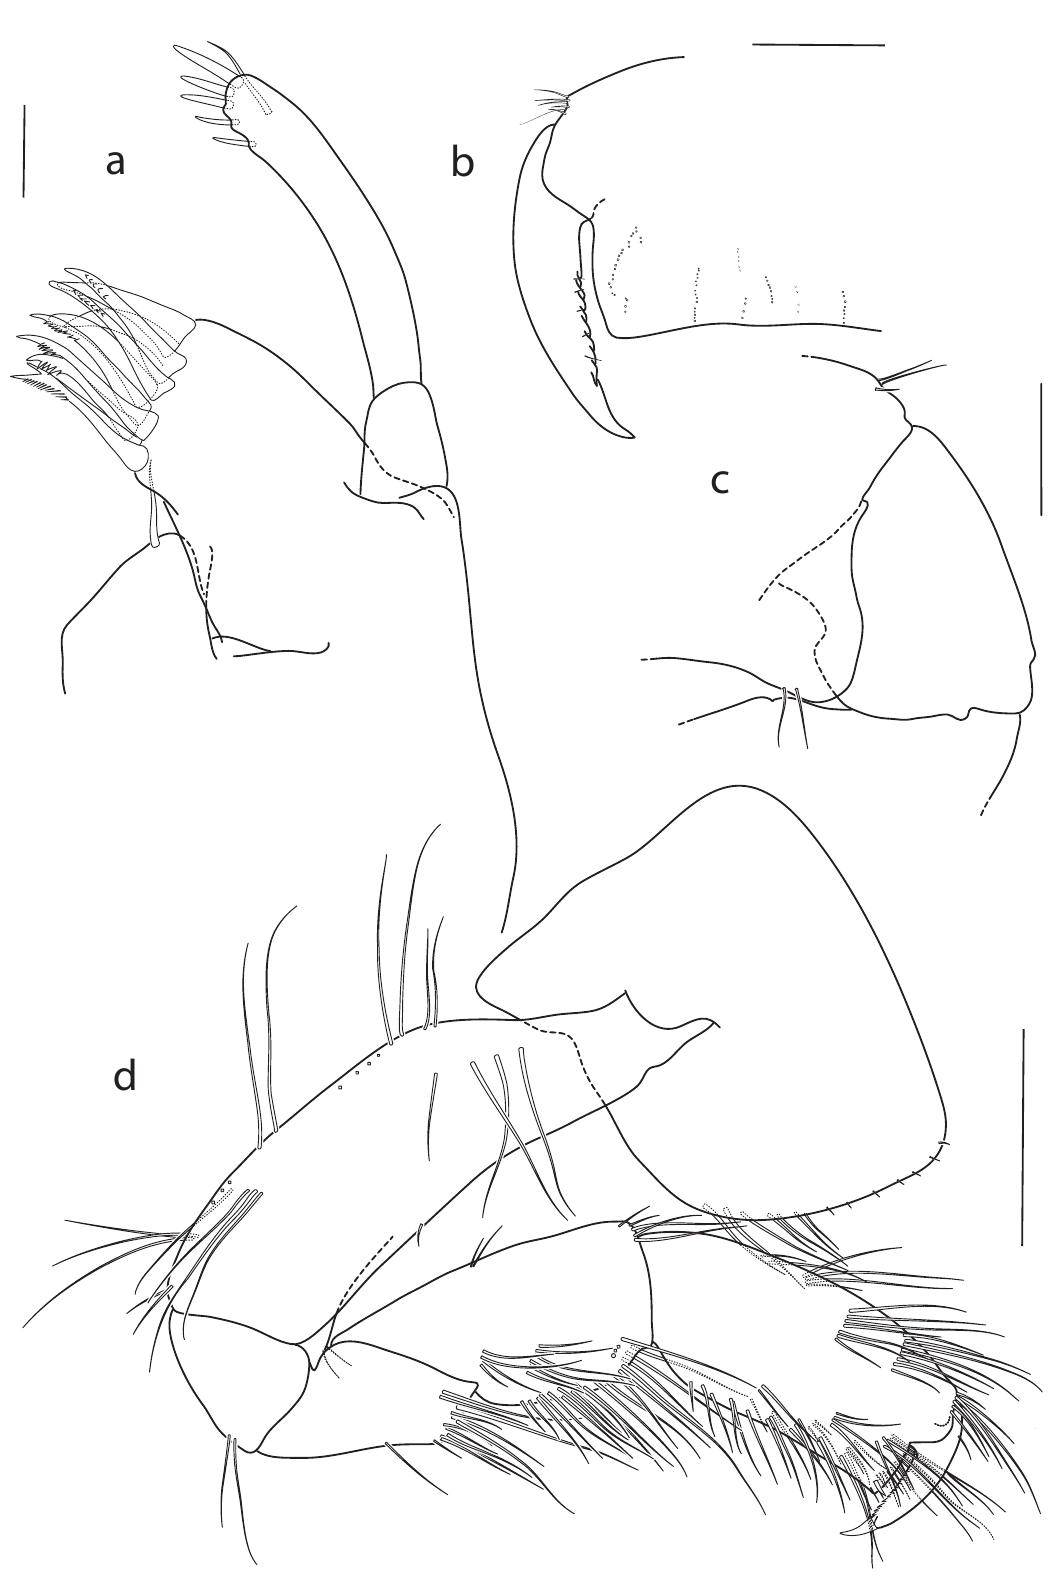
Fig. 3. Sunamphitoe femorata (Krøyer, 1845), ♂, 12 mm (ZMB 34100). a . Maxilla 1. b . Gnathopod 1, chela. c . Lobe of basis of gnathopod 1. d . Gnathopod 1. Scale bars: a–c = 100 µm; d = 500